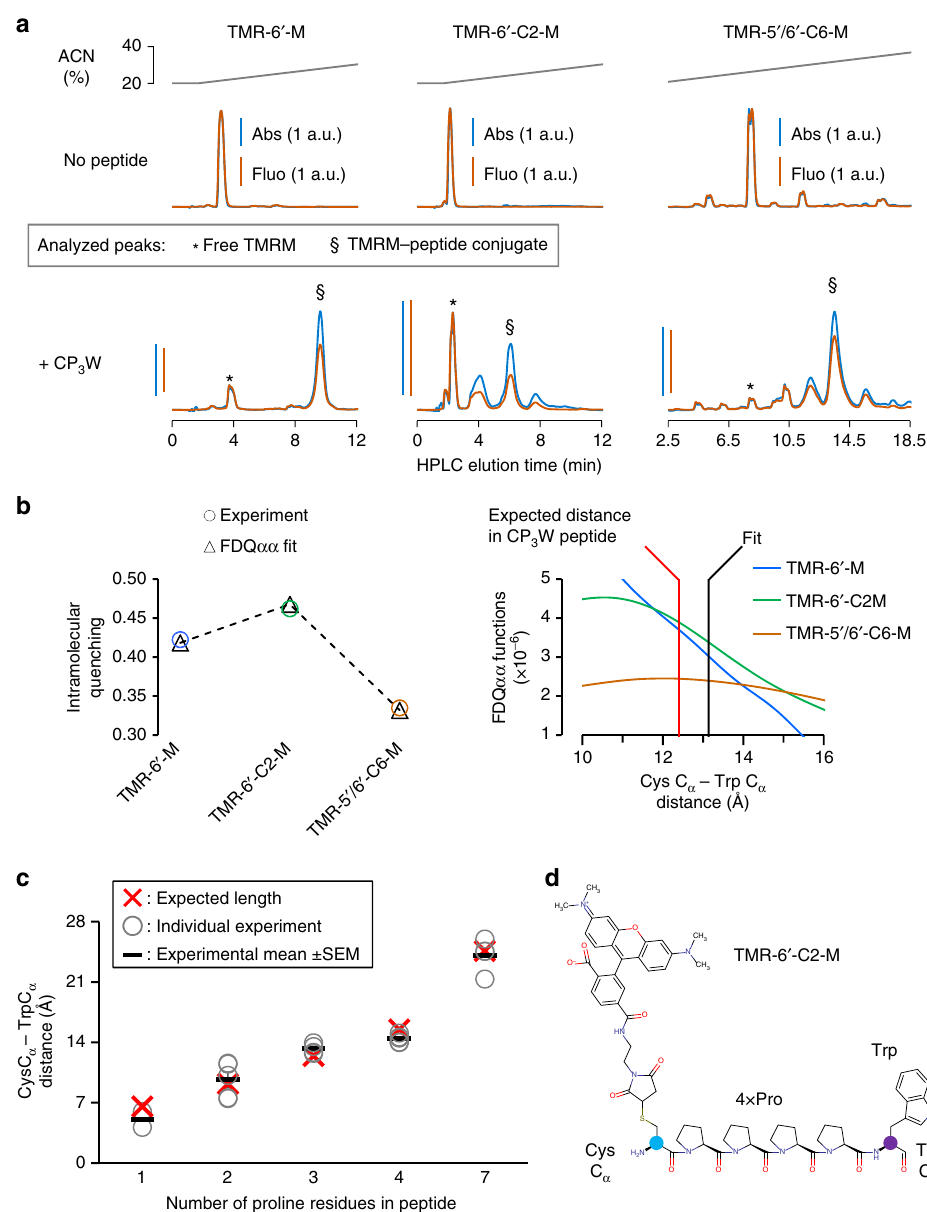
Fig. 6 Evaluating DEPET accuracy using peptide length standards. a Reversed-phase HPLC chromatograms of free TMRM fl uorophore and fl uorophore/ polyproline peptide conjugates. Gray: acetonitrile (ACN) content of the elution buffer; blue: TMRM absorbance ( λ = 550 nm); orange: TMRM fl uorescence ( λ ex = 550nm; λ em = 575 nm). Note that the presence of a Cys-Pro 3 -Trp peptide (i) depletes the free TMRM fl uorophore; (ii) gives rise to conjugate species, shown as new elution bands; and (iii) the conjugate species exhibit less fl uorescence, for the same amount of absorbance; i.e., they are quenched. The most abundant conjugate species were analyzed further, marked by asterisks. b Intramolecular quenching of TMRM fl uorophores of increasing length conjugated to the CP 3 W peptide (circles). The fi ts of these data to the FDQ αα functions (see Fig. 3c & Supplementary Figure 7c) are shown as triangles. The Cys C α – Trp C α distance was estimated to be 13.1 Å; in this peptide with three prolines, it was expected to be 12.4 Å. The c parameter was 1.38 × 10 5 . The expected and fi t distances in relation to the FDQ functions are shown on the right. c Summary of all peptide length determination experiments. The number of experimental replicates were 2, 5, 4, 5, 4 for peptides with 2, 3, 4, 5 or 7 Pro, respectively. Open circle: individual experiment; dash: experimental mean; red cross: nominal length. On average, the FDQ-determined length estimates were off by ~1.3 Å (see Supplementary Table 4). d Molecular structure of a Cys-Pro 4 -Trp peptide conjugated to the TMR-6 ′ -C2-M fl uorophore. The Cys and Trp C α atoms are indicated in blue and purple,